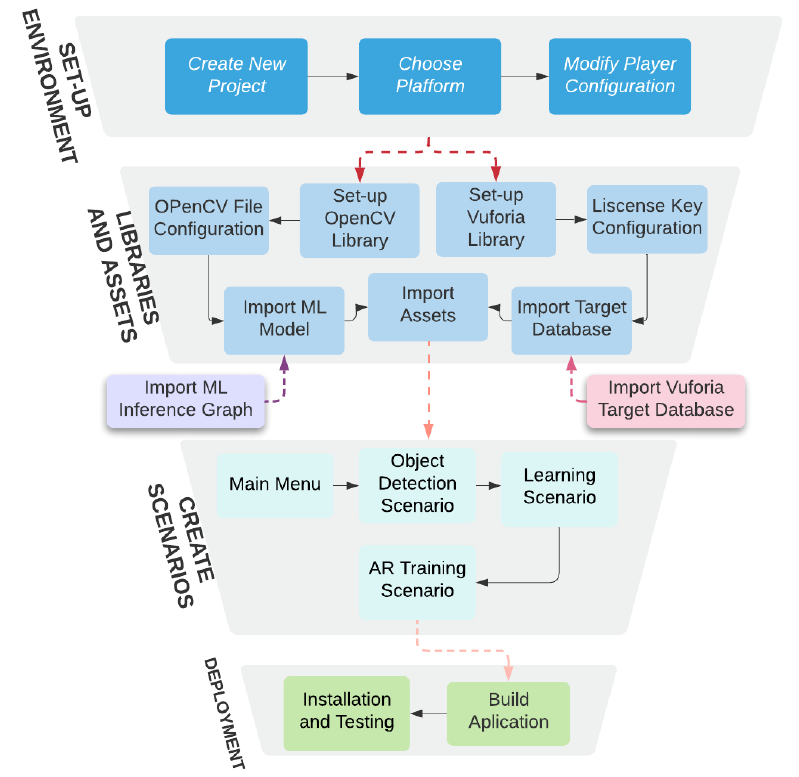
Figure 6. Lab training application